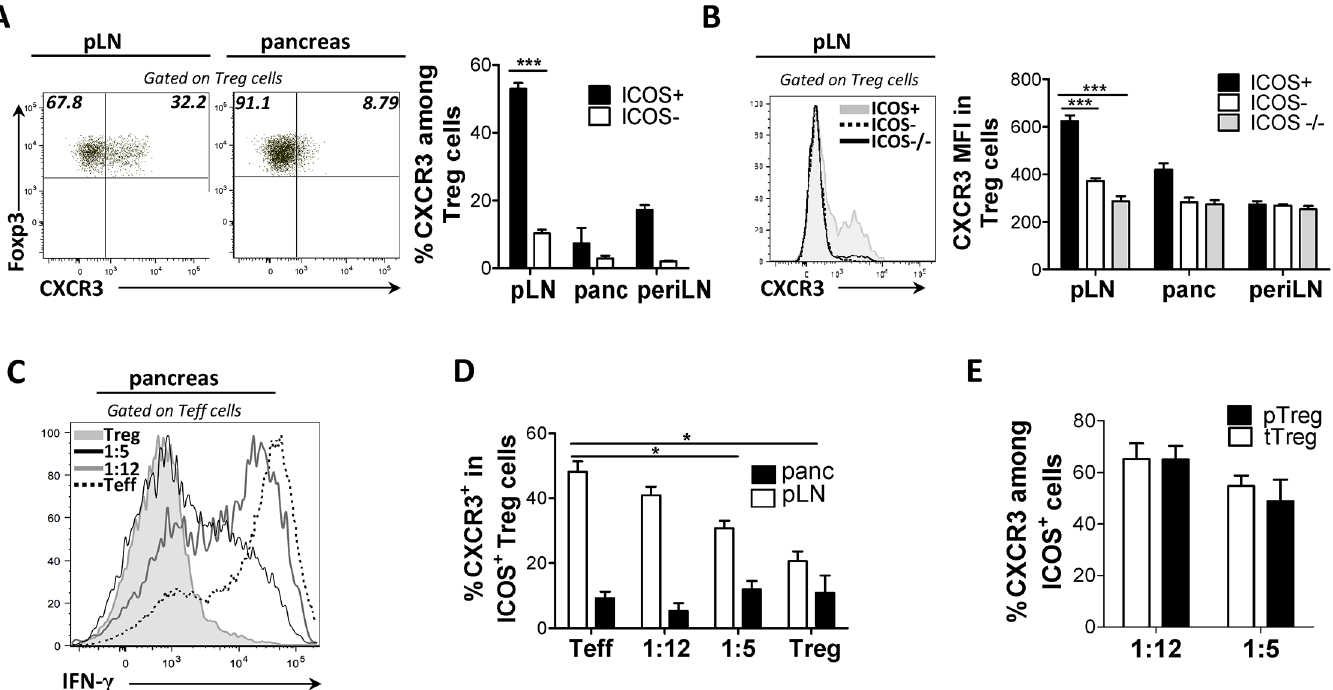
Fig 1. Autoreactive T cell-mediated inflammation induces CXCR3 expression by ICOS + T reg cells prior to T1D onset. Cell suspensions of pancreas and draining LN from 4 week old (A, B) WT and (B) ICOS -/- BDC2.5 mice were assessed for the frequency of CXCR3 + cells and levels of CXCR3 expression (MFI) between the ICOS + and ICOS - subsets of T reg cells. (C and D) NOD.TCR α -/- mice received MACS sorted BDC2.5 CD4 + CD25 + (T reg , 0.75X10 5 ) or CD4 + CD25 - (T eff , 7.5X10 5 ) cells alone or at the indicated T reg/ T eff cell ratios. When the T eff cell recipient mice displayed hyperglycemia ( > 33mmol/L), mice were sacrificed and expression of IFN- γ by T eff cells (C) and CXCR3 + percent cells among the ICOS + T reg cell subset were assessed. (E) NOD.TCR α -/- mice received the indicated ratios of FACS-sorted Thy1.2 + T reg cells to 7.5X10 5 BDC2.5 Thy1.1 + CD4 + Foxp3 - T eff cells. After 14 days, the Thy1.2 (tT reg ) and Thy1.1 + (pT reg ) subsets of ICOS + T reg cells were compared for percent CXCR3 + cells. (n = 4, peri LN = pooled axial, brachial and inguinal peripheral lymph nodes).